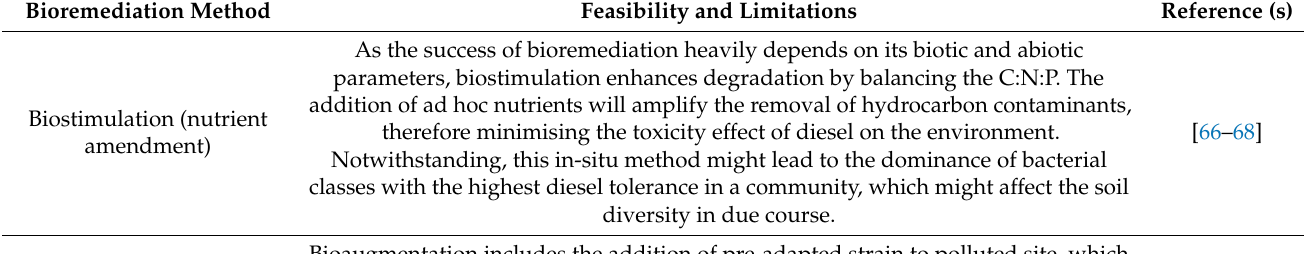
Table 2. Proven or potential feasibility and limitations or bioremediation application in Antarctica. Bioremediation